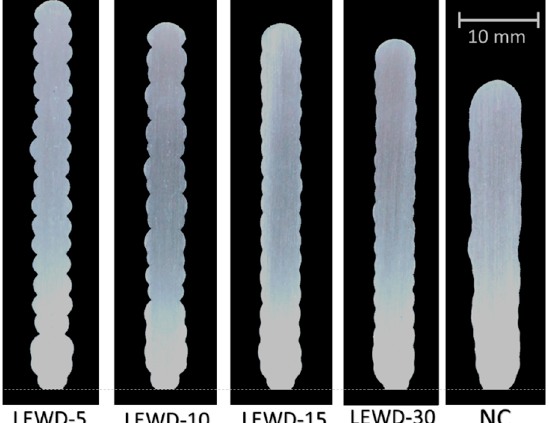
Figure 5. Qualitative effect of the LEWD parameter on the geometrical quality of the 350 mm-long walls.